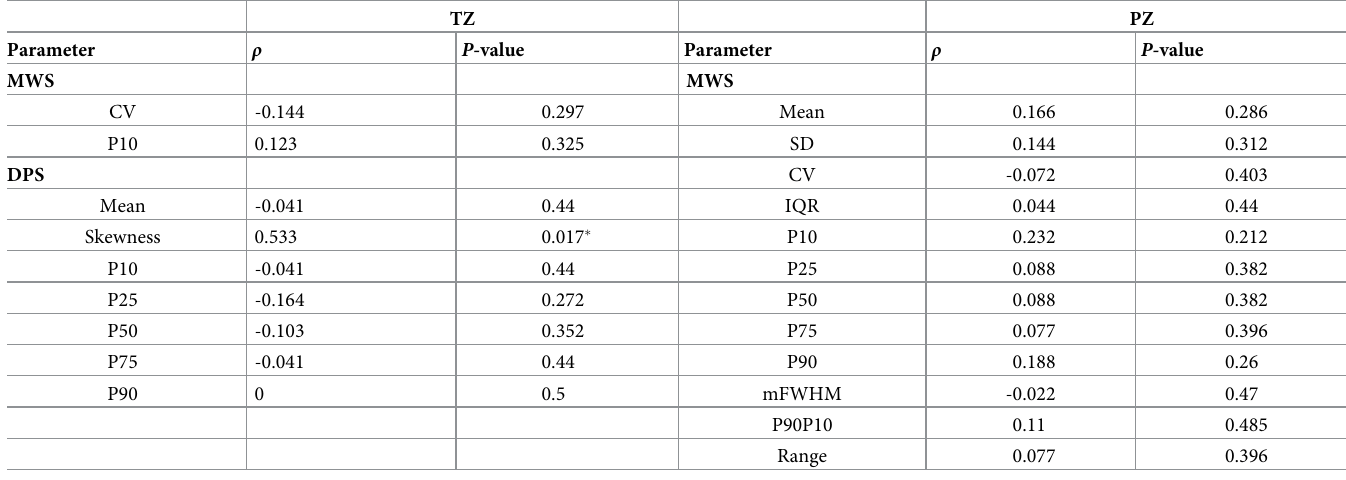
Table 4. The Spearman correlation coefficient for correlation of histogram parameter with Gleason